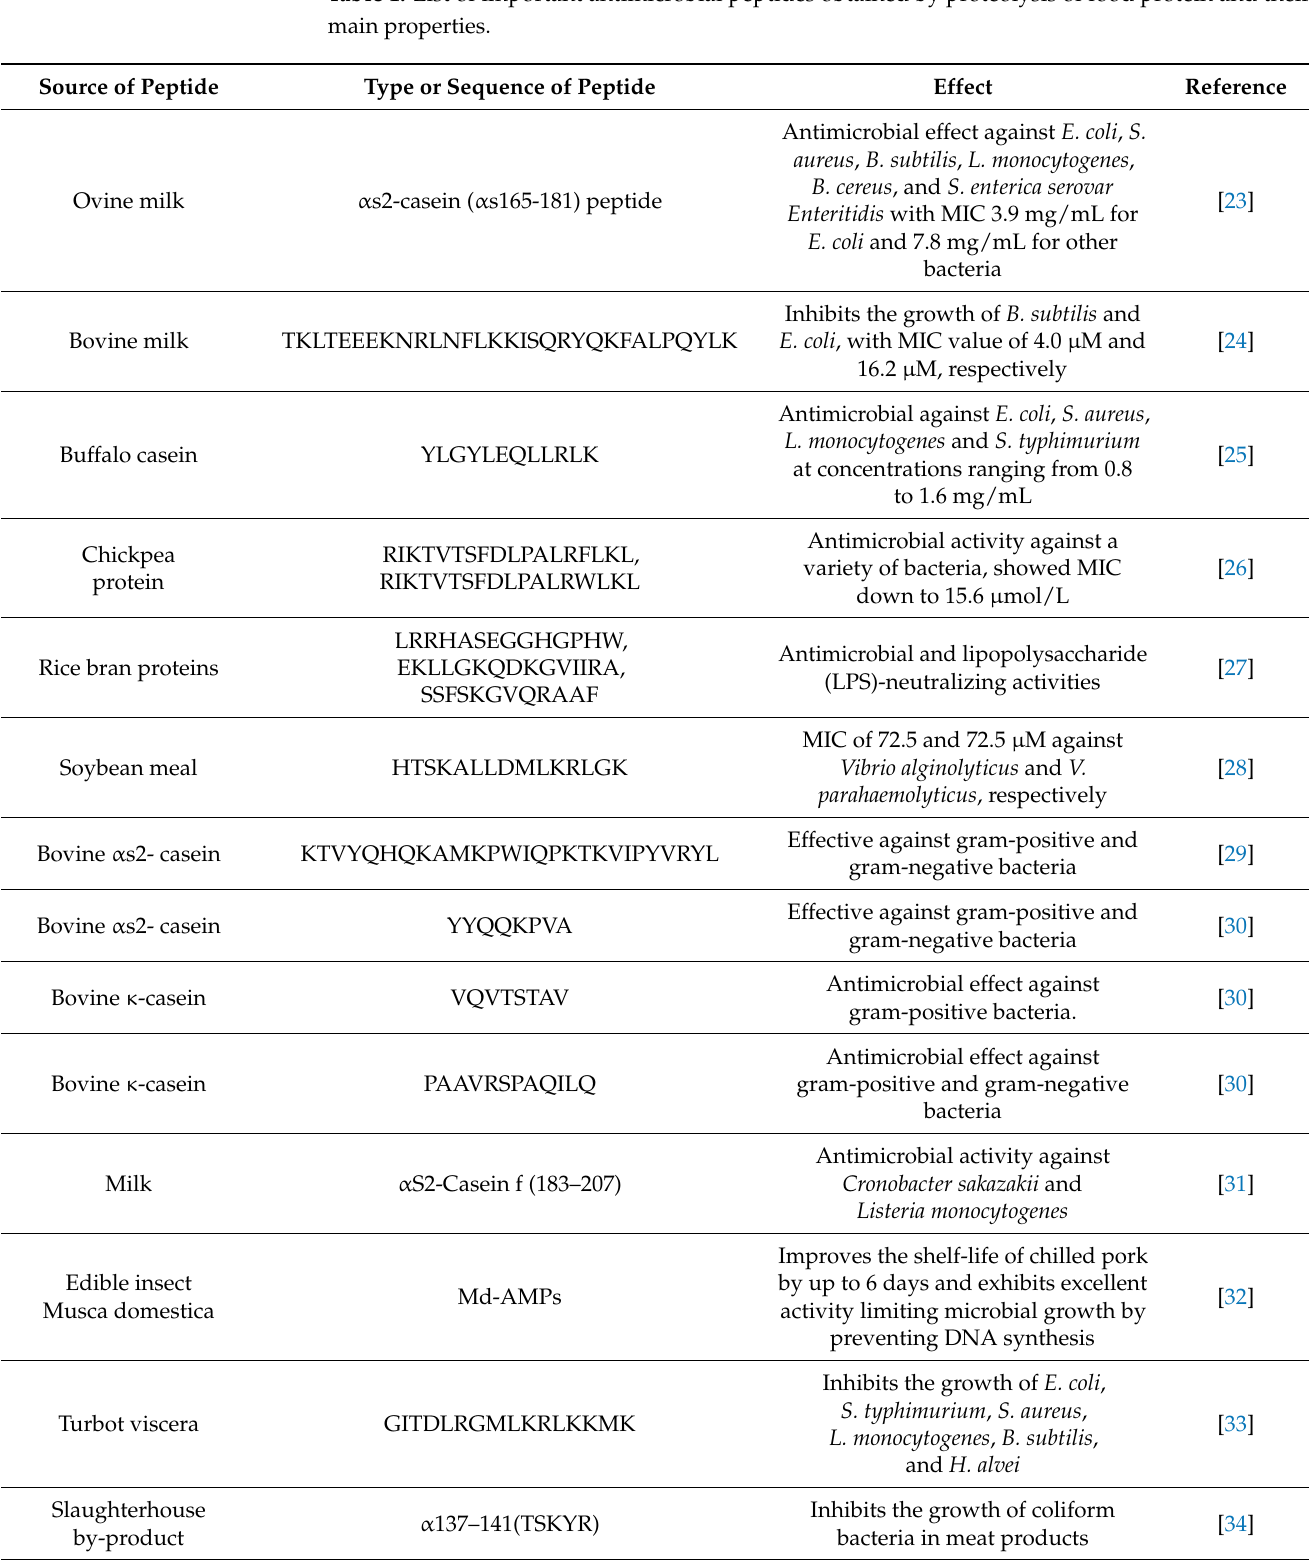
Table 1. List of important antimicrobial peptides obtained by proteolysis of food protein and their main